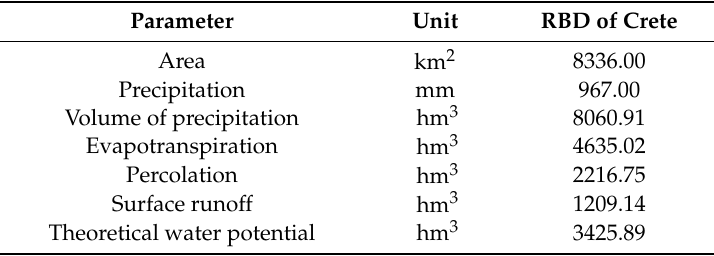
Table 3. General hydrological data (annual average values of a normal year) for the river basin districts (RBDs) of the island of Crete.